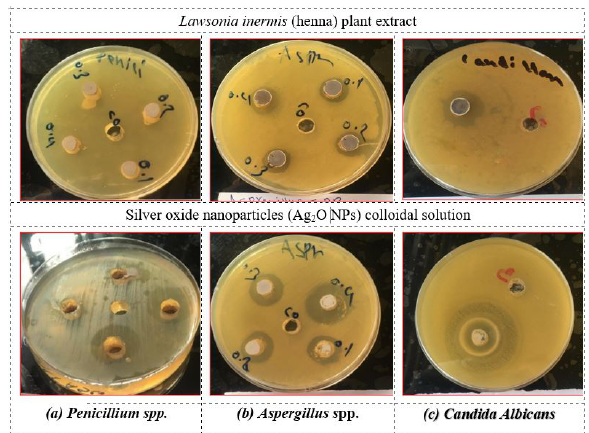
Figure 8: Antifungal assay test using well diffusion method of Law- sonia inermis (henna) plant extract Ag 2 O NPs against (a) Penicillium spp. , (b) Aspergillus spp. , and (c) Candida albicans